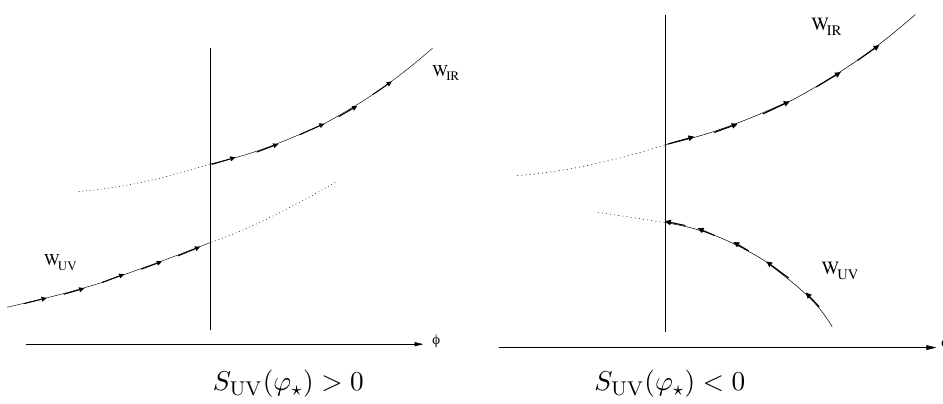
Figure 5 . Junction rules in (cid:12)eld space. The vertical solid line indicates the locus of the